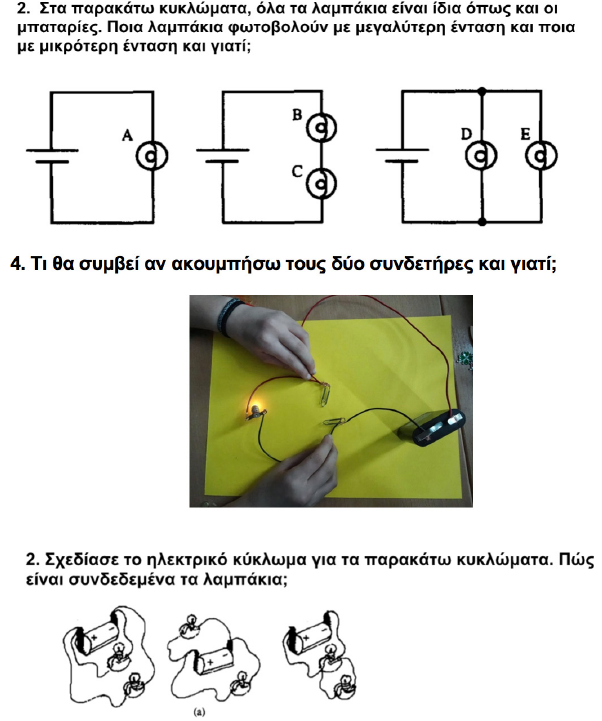
Fig. 8. Sample of students’ tests [25]